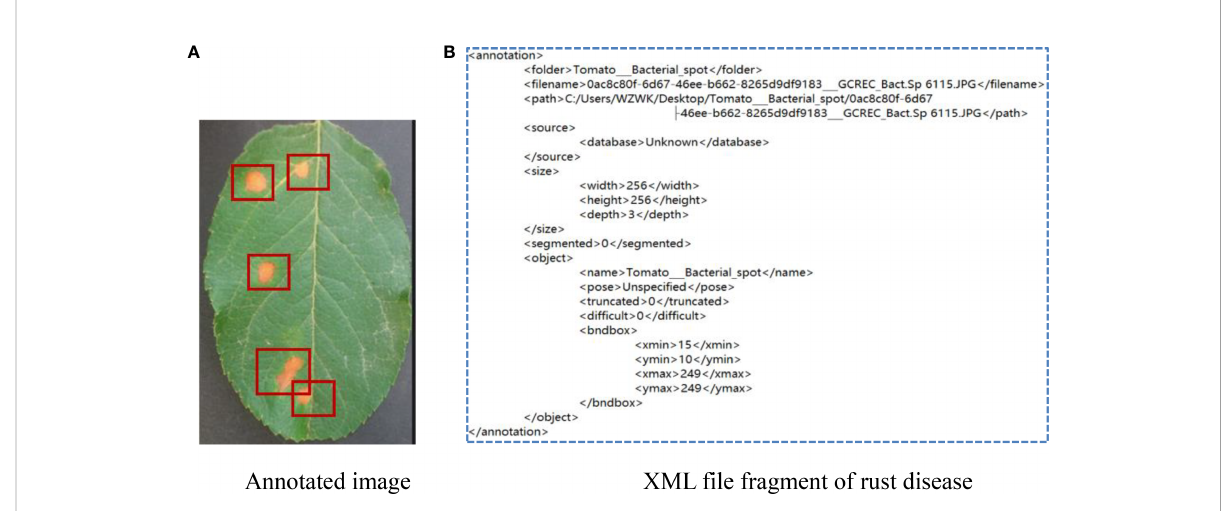
FIGURE 6 Annotation of apple rust disease leaf image. (A) Annotated image. (B) XML fi le fragment of rust